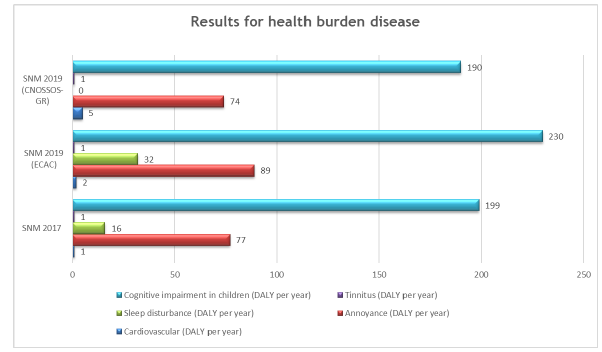
Figure 10: Main results for the health burden of disease